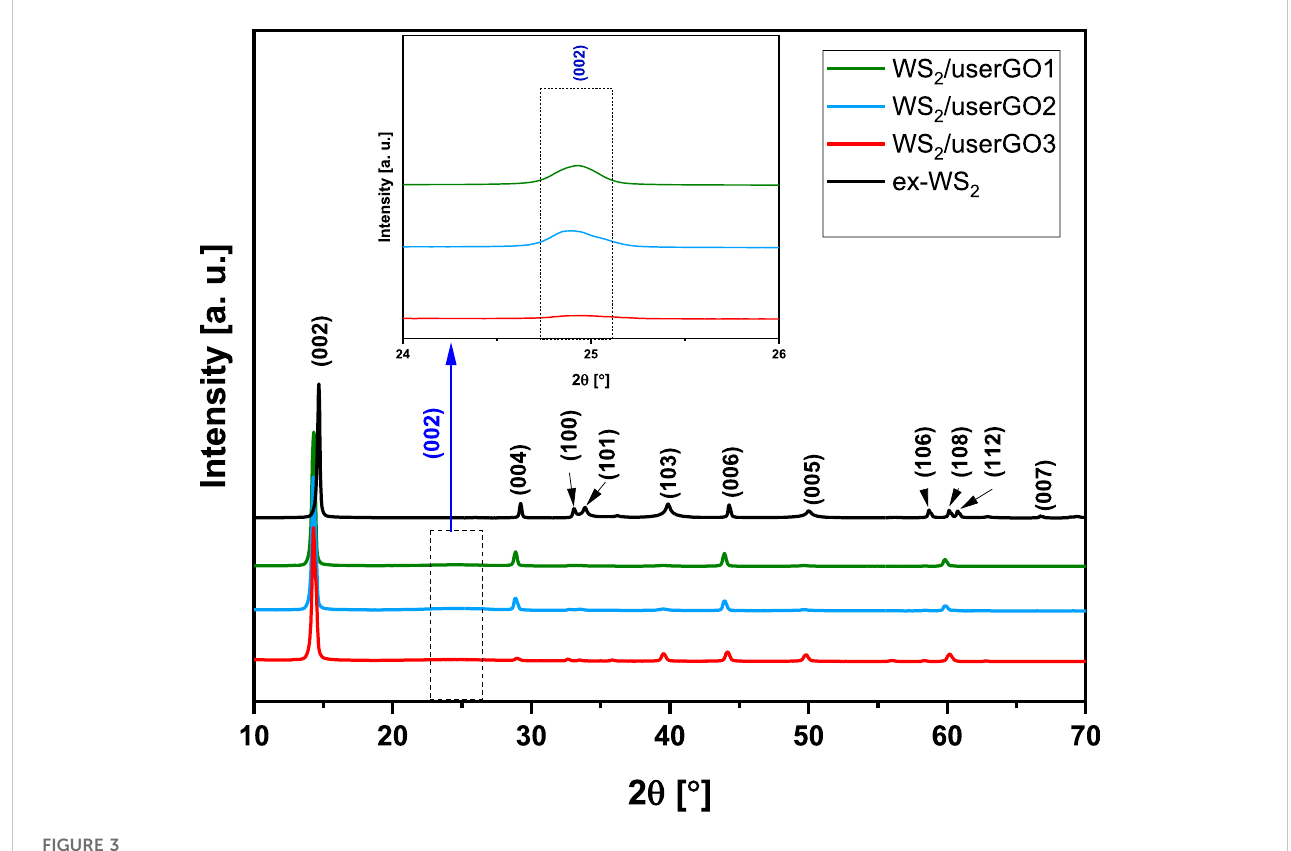
FIGURE 3 XRD pattern of WS 2 /userGO1, WS 2 /userGO2, WS 2 /userGO3 fi lm, and ex-WS 2 .